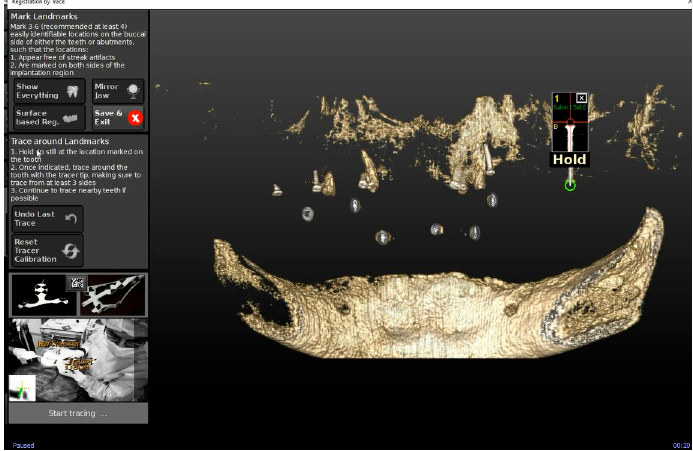
Figure 2. Head tracker used in the upper jaw for dynamic navigation Trace and Place (TaP).